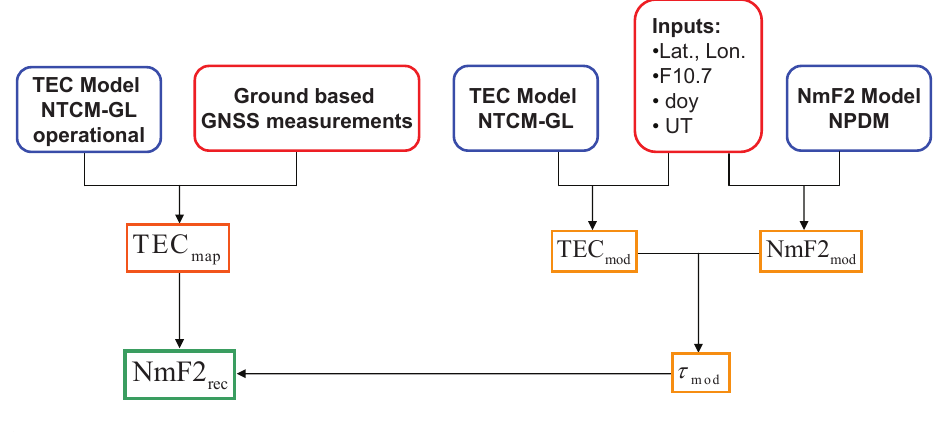
Fig. 1. Diagram of Nm F2 reconstruction approach.